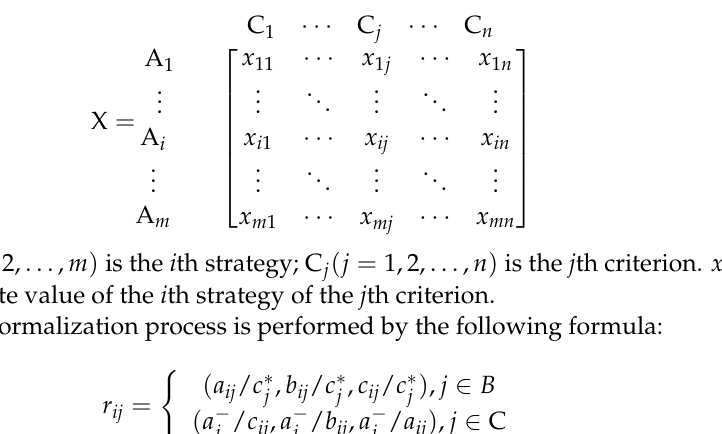
Figure 2. The main steps of the proposed methodology.